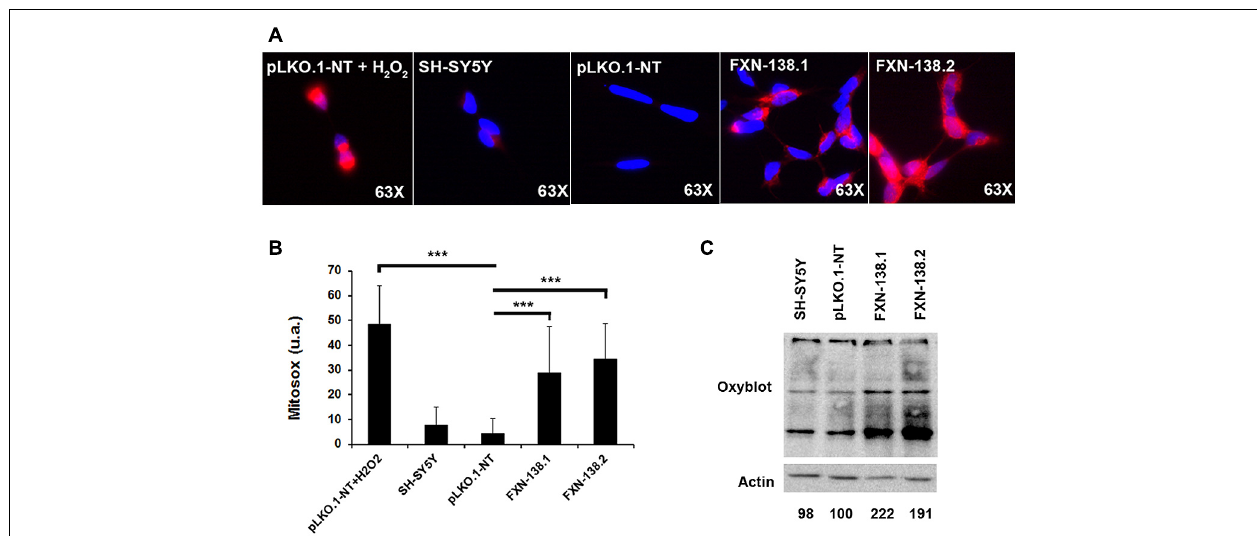
FIGURE 5 | Detection of protein oxidation and superoxide abundance. (A) Detection of superoxide in live cells of SH-SY5Y clones using MitoSox TM Red superoxide indicator. Representative images of MitoSOX stained cells fromSH-SY5Y, pLKO.1-NT, FXN-138.1, and FXN-138.2. pLKO.1-NT was treated with or without H 2 O 2 . (B) Quantitative analysis of MitoSOX red fluorescence intensity. Fluorescence level is presented relative to cell area in every clone. Student’s t -test, FXN-138.1 p = 1.8 × 10 − 7 , FXN-138.2 p = 6 × 10 − 14 versus pLKO.1-NT. (C)